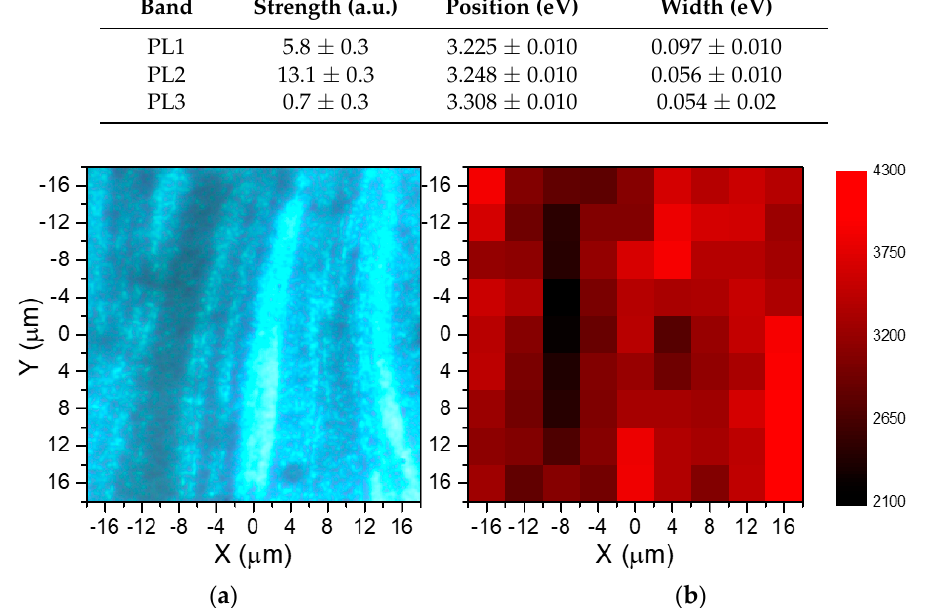
Figure 9. Uncapped quartz sample Q10, 1000 c. ( a ) White light photography and ( b ) integral PL intensity (arb. units) over the same area of the substrate with 4 × 4 μ m 2 resolution.